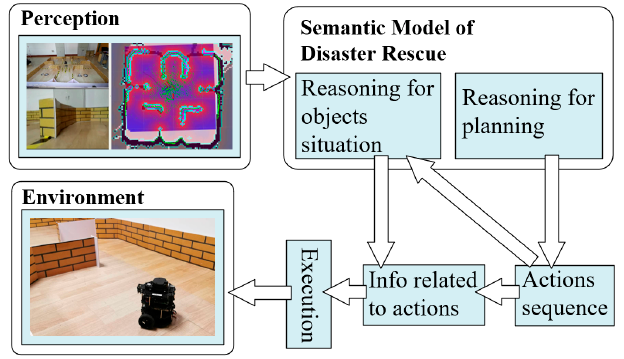
Figure 16. The specific implementation process of study case on TurtleBot3.